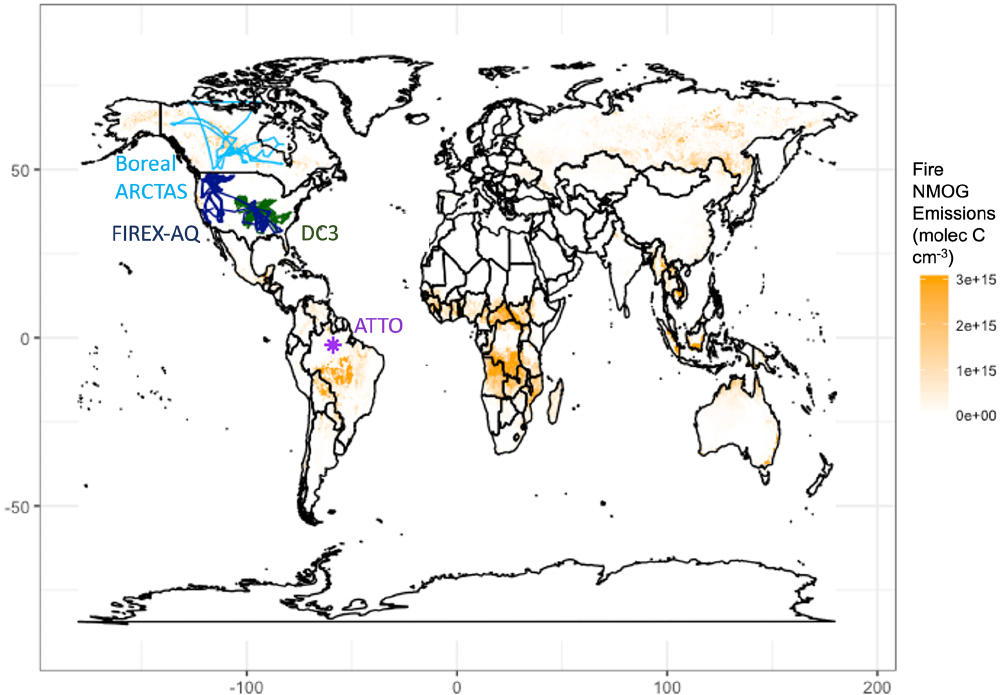
Figure 2. Measurement locations of campaigns used in this analysis overlaid on annual mean NMOG emissions from fires across 1997–2019 from GFED4s. Boreal ARCTAS is in light blue, FIREX-AQ in dark blue, DC3 in dark green, and ATTO in purple.